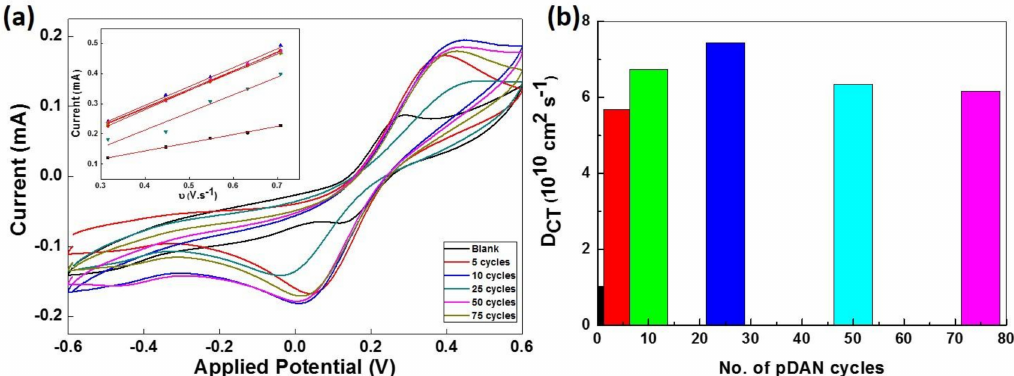
Figure 5. ( a ) Cyclic voltammogram of CVD graphene and pDAN modified CVD graphene with different scan cycles in 5 mM K 3 [Fe(CN) 6 ] in PBS at a scan rate of 50 mVs − 1 . Inset shows the linear dependency of the peak current vs. square root of scan rate for CVD graphene and pDAN modified CVD graphene at different scan cycles. ( b ) Bar chart illustrating the change in charge transfer diffusion coefficient vs. number of pDAN scan